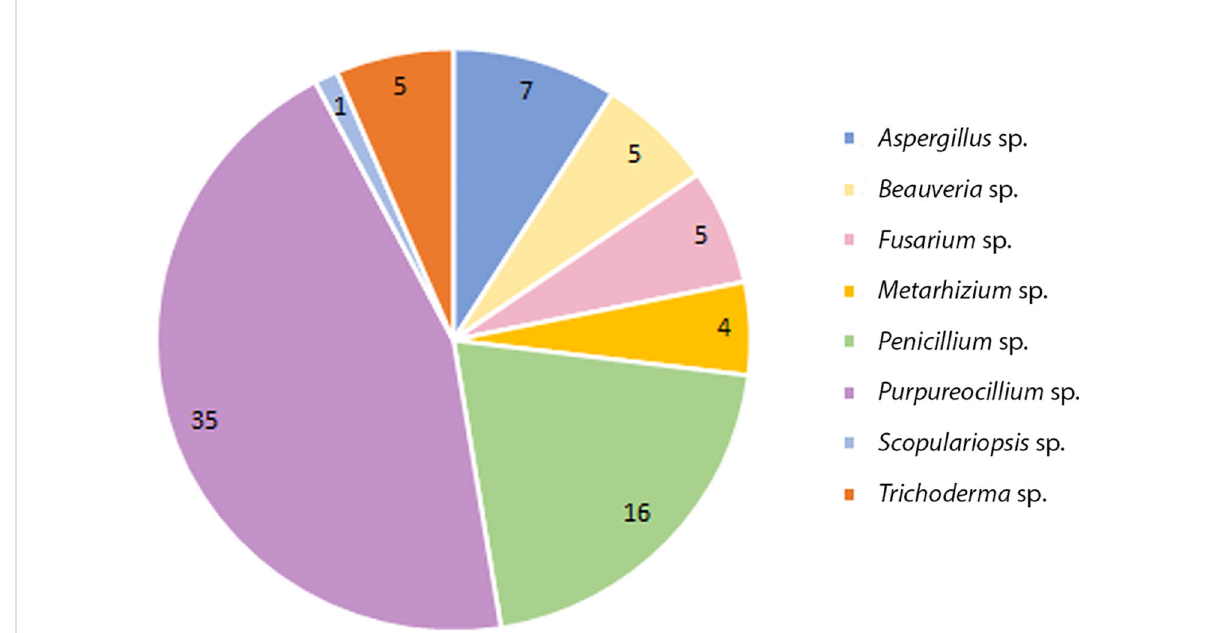
FIGURE 1 Total number of species collected from soil from domiciles with cases of feline sporotrichosis at Petro ́ polis and Vassouras, Rio de Janeiro